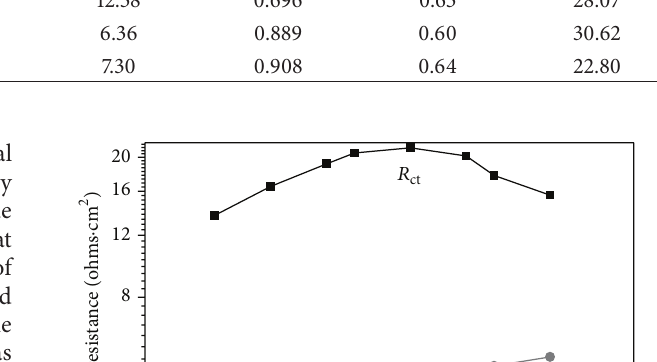
values obtained from 𝑅 𝑝 and EIS ct